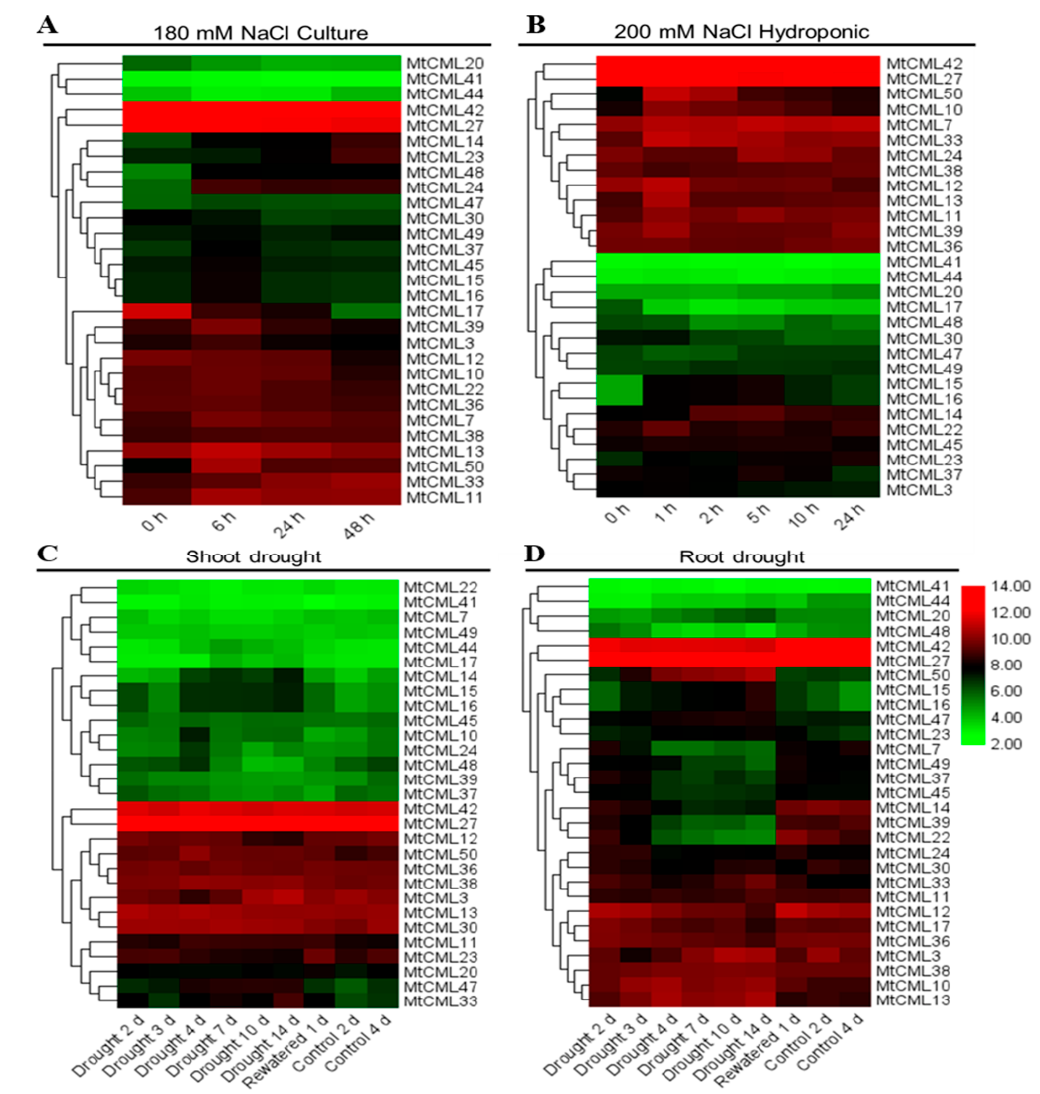
Figure 6. Transcript profile of MtCML genes in response to salt and drought stresses. Genome-wide microarray data of M. truncatula in different tissues at various developmental stages and the response to drought and salt were retrieved from M. truncatula Gene Expression Atlas (MtGEA, https: // mtgea.noble.org / v3 / ). ( A ) Two-day-old seedlings were placed on half strength of MS medium containing 180 mM NaCl for 0, 6, 24 and 48 h, ( B ) Two-week-old seedlings were treated in a nutrient solution containing 200 mM NaCl for 1, 2, 5, 10 and 24 h as hydroponic treatment, while those growing in the nutrient solution as control. C and D , 24-day-old seedlings growing in soil were stopped watering for drought treatment for 14 d before rewatering, followed by sampling shoot and roots, respectively for analysis of gene expression. The expression levels of the MtCML genes are shown as the log 2 -based fluorescence intensity values from the microarray data (MtGEA, https://mtgea.noble.org/v3/).